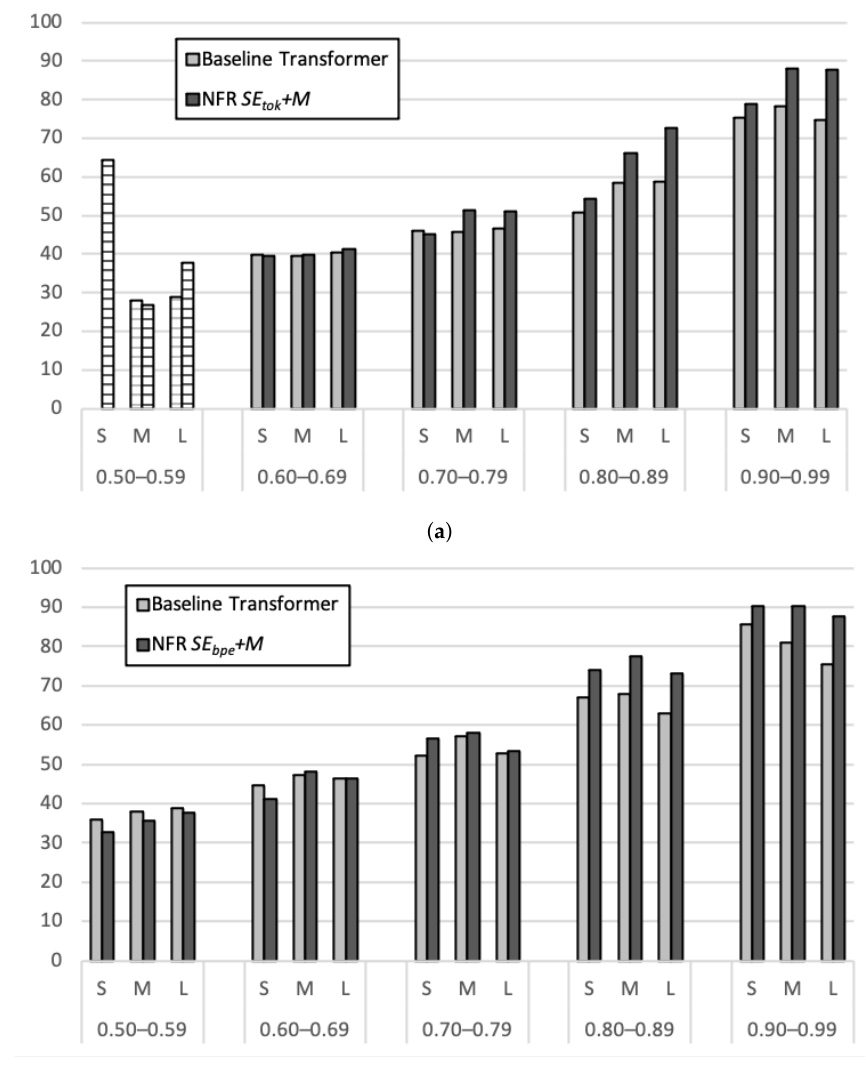
Figure 4. Comparison of ( a ) SE tok +M and ( b ) SE bpe +M with Baseline Transformer for different match ranges and sentence lengths, HU-EN. Note that, in ( a ), the bin sizes in the lowest match range are very small (i.e., between 3 and 5 sentences), so the reported BLEU scores for these bins are not reliable. S refers to sentences of length 1–10, M 11–25, and L over